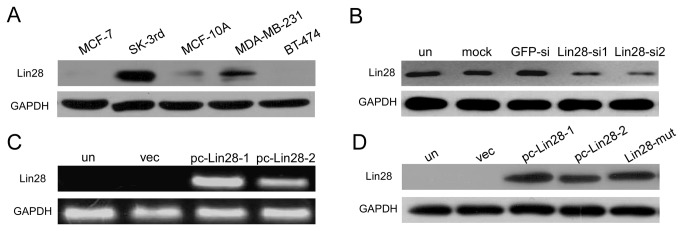
Lin28 expression in breast cancer cell lines and the transfection efficiencies of the Lin28-siRNAs, Lin28-expressing plasmid and Lin28-mutant plasmid.A. Differential expression of Lin28 was analyzed by Western blotting in multiple breast cell lines, including MCF-7, SK-3rd, MCF-10A, MDA-MB-231 and BT-474. B. Western blotting showed that transient transfection of either of the Lin28-siRNAs in MDA-MB-231 cells, compared with GFP-siRNA transfection, led to a reduction in the expression of Lin28. C and D. Lin28 expression was determined by PCR (C) and Western blotting (D) in MCF-7 cells that were stably transfected with pc-Lin28-1, pc-Lin28-2 (C and D) or Lin28-mut (D). GAPDH was used as a loading control.